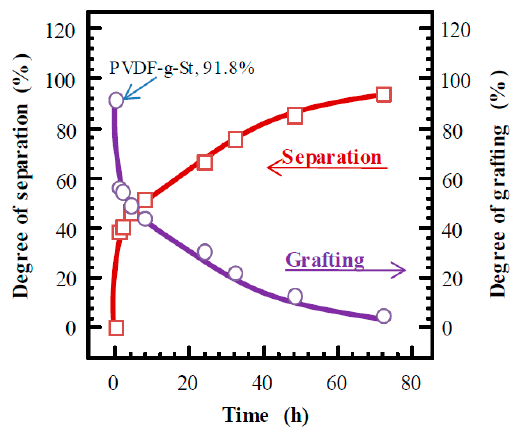
Figure 4. Degree of separation and degree of grafting of the residual PVDF– g –St film (initial degree of grafting, 91.8%) in xylene at 138 ° C as a function of extraction time. In contrast, due to the loss of polystyrene, the degree of grafting decreased during the extraction. As shown in Figure 4, the degree of grafting dropped sharply from 91.8 to 49.2% in the initial 4 h and then slowly decreased to 5.5% after 72 h of extraction time as the polystyrene was removed from the grafted film.